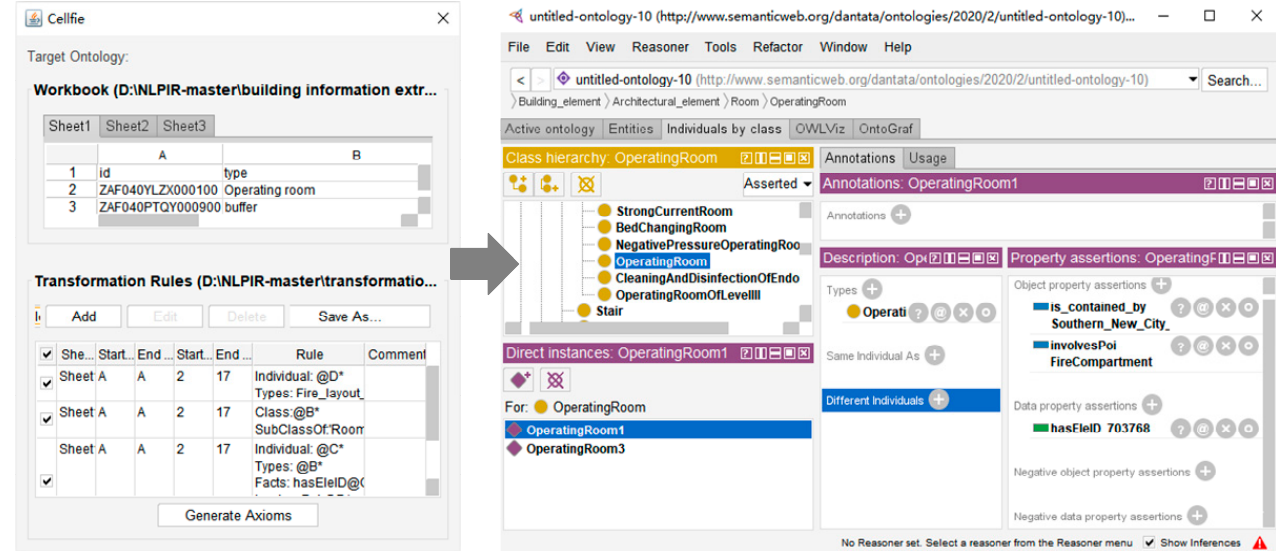
Figure 16. Mapping spreadsheet data to ontology individuals via Cellfie tools.